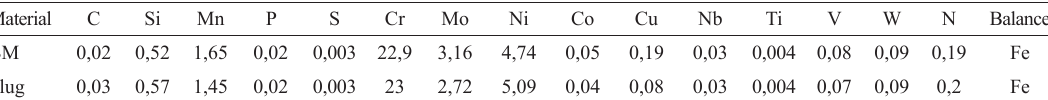
Table 1: Chemical composition of base material (BM) and Plug (wt%). Material